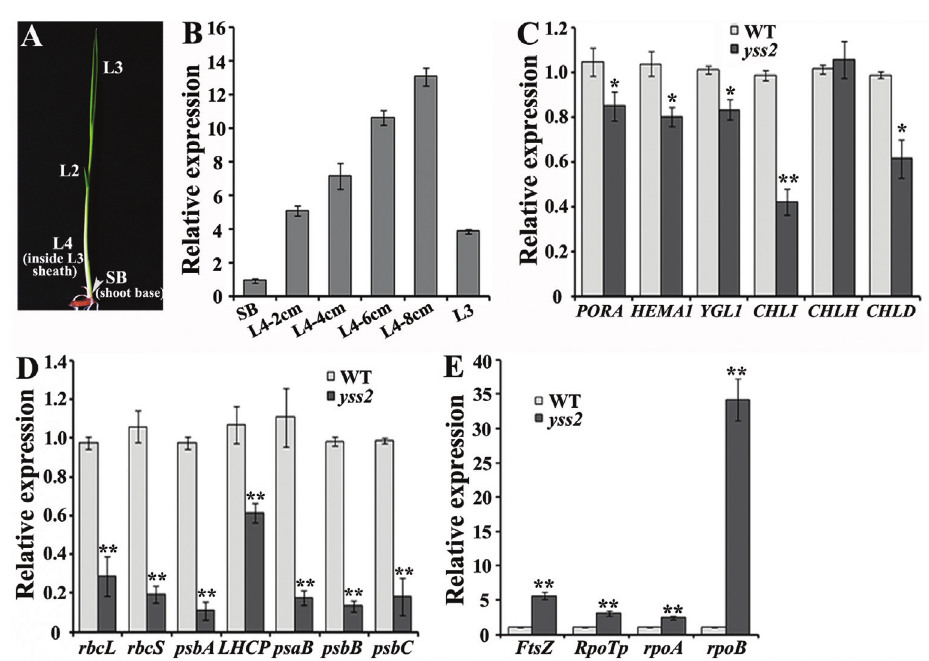
Figure 6 - Expression analysis of YSS2 and genes associated with Chl biosynthesis, photosynthesis and chloroplast biogenesis. (A) Diagram of rice seed- ling at the L3 stage in which the leaf 3 was fully expanded. SB (shoot base) indicates a 2 mm piece from the bottom of shoot. L2, L3 and L4 (inside L3 sheath) respectively indicate the second, third, and fourth leaf at the L3 stage. (B) Expression analysis of YSS2 in SB, L4-2cm, L4-4cm, L4-6cm, L4-8cm, and L3 of wild type seedlings at the L3 stage grown in a paddy field. L4-2cm, L4-4cm, L4-6cm, and L4-8cm represent 2cm, 4cm, 6cm, and 8cm pieces from the bottom of shoot, respectively. (C, D and E) Real-time RT-PCR analysis of genes involved in Chl biosynthesis, photosynthesis and chloroplast biogenesis.TotalRNAwasextractedfromleaf3ofwildtypeand yss2 mutantatthethree-leafstageinapaddyfield.The ubiquitin genewasusedasanin- ternal control. Data are means (cid:4) SD of three replicates. **p = 0.01 and *p = 0.05, by Student’s t